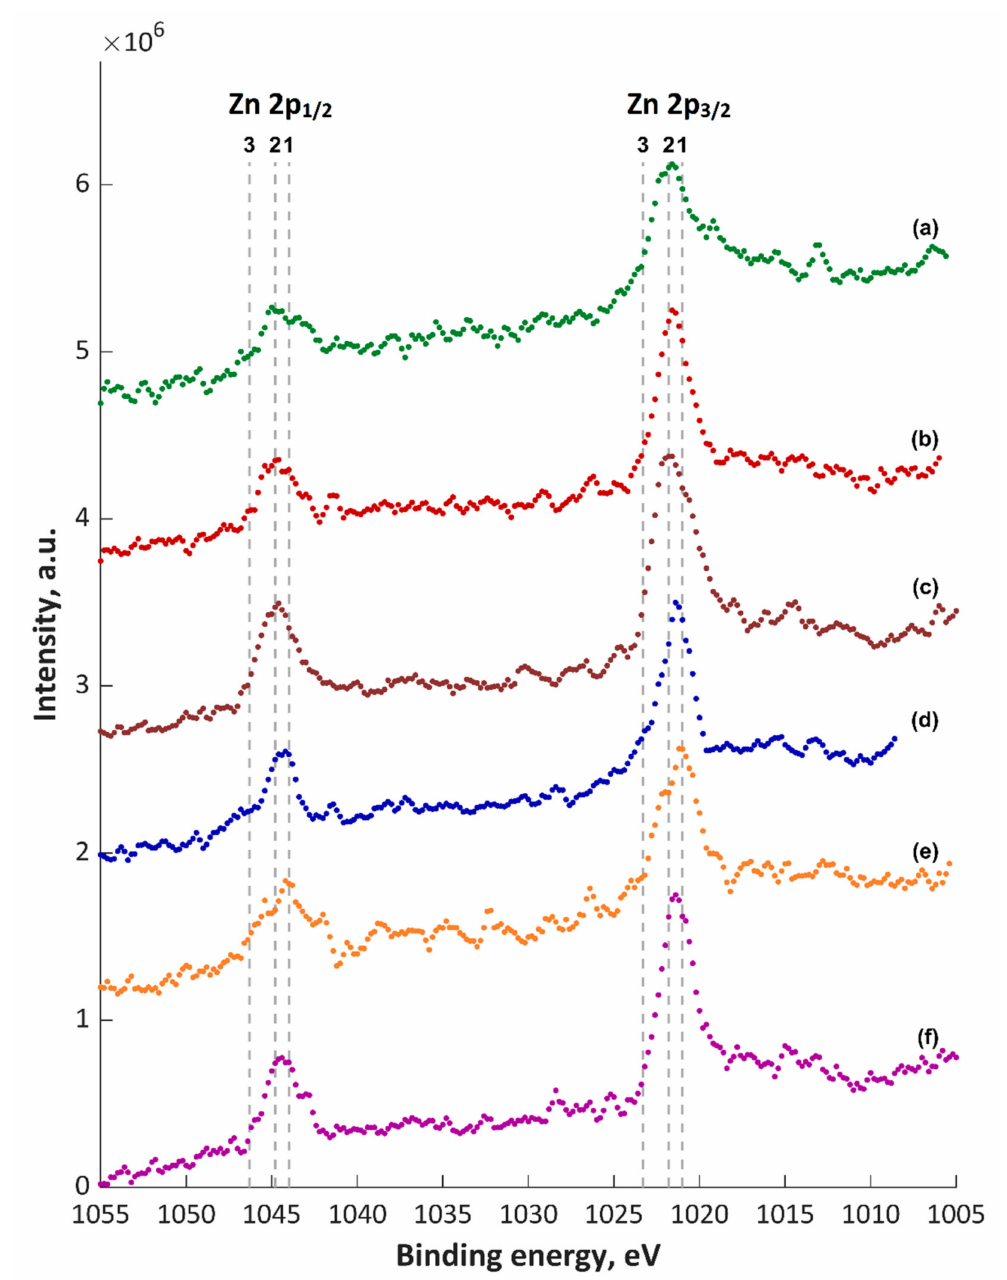
Figure 7. XPS Zn 2p spectra of PEO coatings: ( a ) TiZnCu-35; ( b ) TiZnCu-135; ( c ) TiZnCuCa-35; ( d ) TiZnCuCa-135; ( e ) TiZnCuMg-35; and ( f ) TiZnCuMg-135. 1, ZnO; 2, Zn(OH) 2 ; 3, Zn 3 (PO 4 ) 2